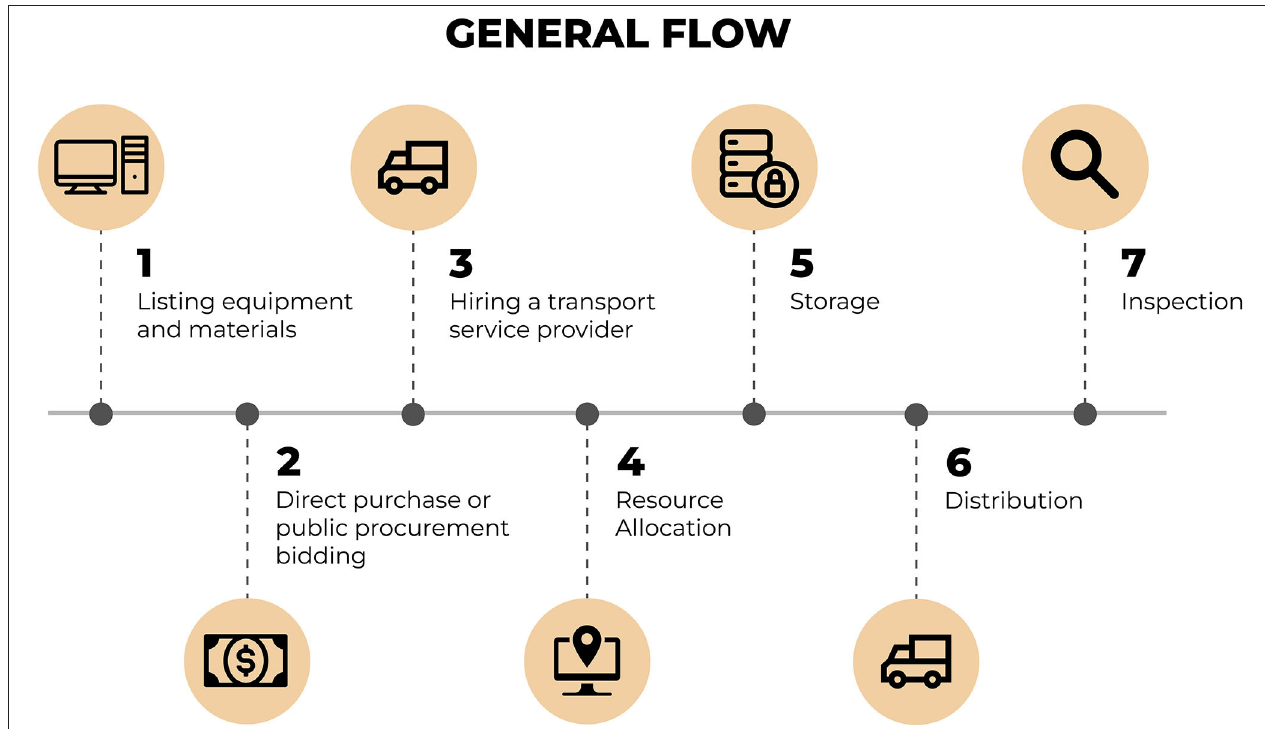
FIGURE 3 | Flow of steps for the process of acquisition, distribution, and delivery of the equipment and/or materials. Source: graphic developed by the